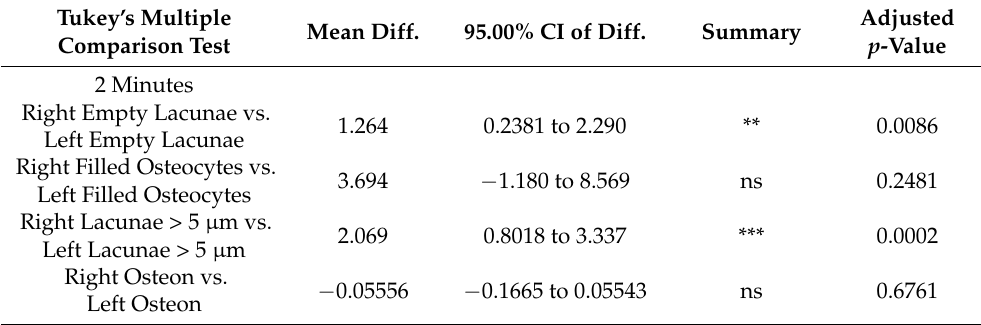
Table 8. Left and right 2 min implant inter-group comparison